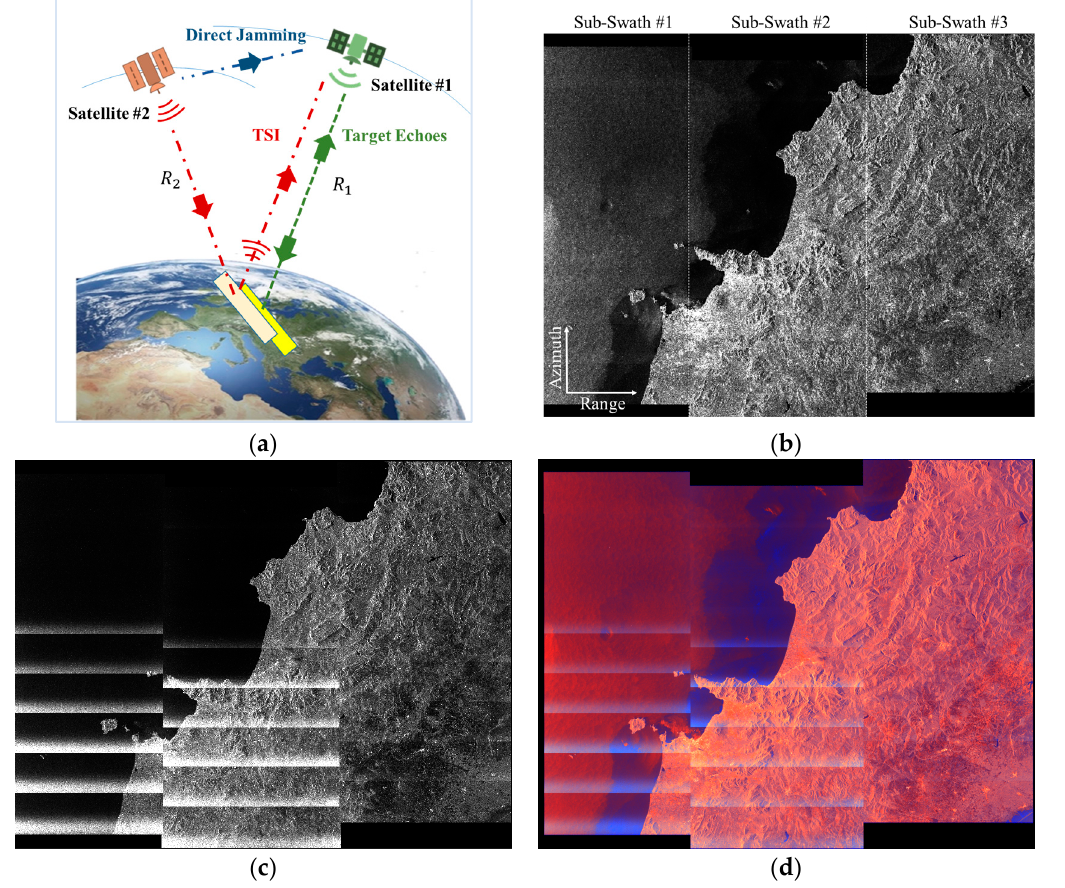
Figure 7. Illustration of terrain scattered interference. ( a ) Geometry of space-borne RFI interfering case. A case example in real measured C-band Sentinel-1 SAR data: ( b ) VV image, ( c ) VH image and ( d ) pseudo color coded image with VV-Red, VH-Green, and VV/VH-Blue.